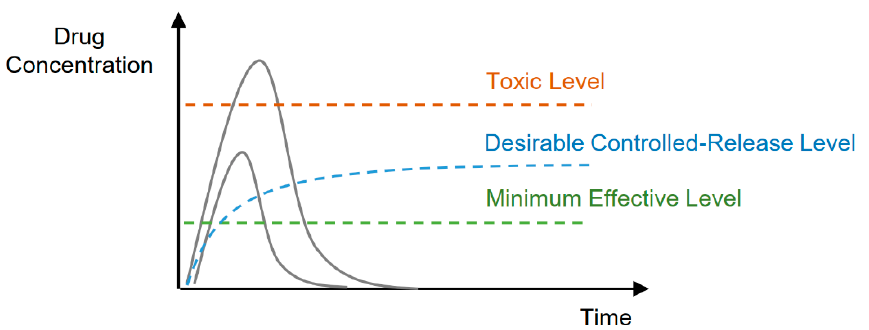
Figure 10. The graph presents the drug concentration over time connected with the levels of pharmaceutic effectivity. ceutic